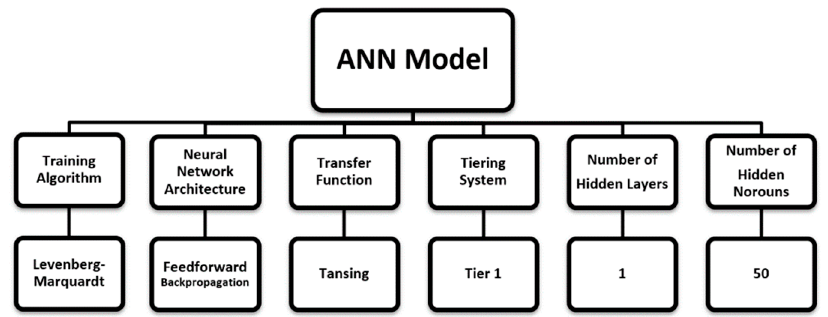
Figure 2. Computational fluid dynamic (CFD) model preparation workflow.